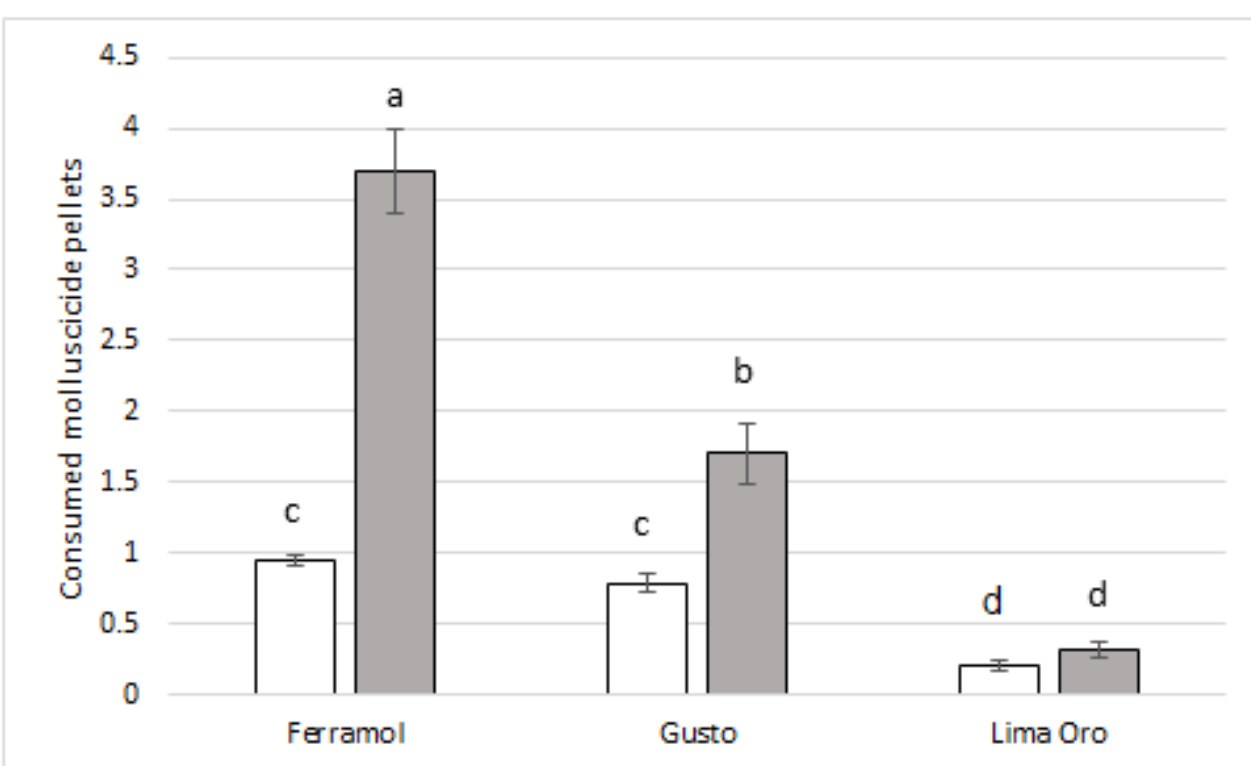
Figure 1. Mean (± standard error of the mean) consumption of molluscicide pellets during the first